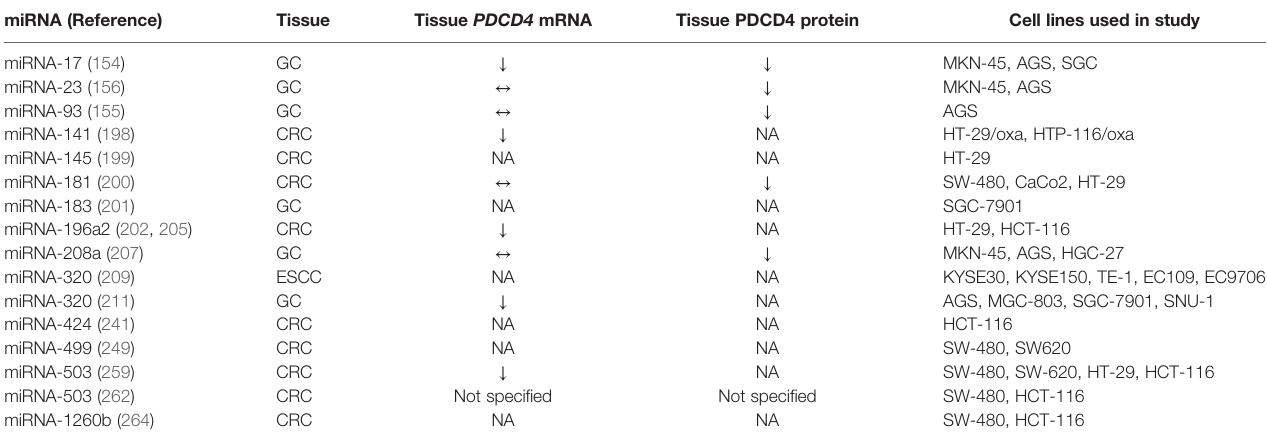
TABLE 1 | MicroRNA and PDCD4 expression in cancers of the gastrointestinal tract. miRNA